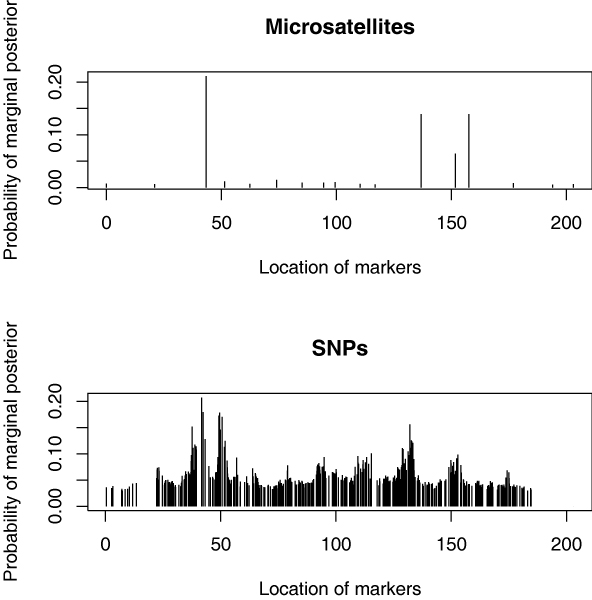
Comparisons between microsatellites and SNPs on chromosome 4. Both results from microsatellites and SNPs show similar patterns for markers having the evidence being linked to the disease genes.